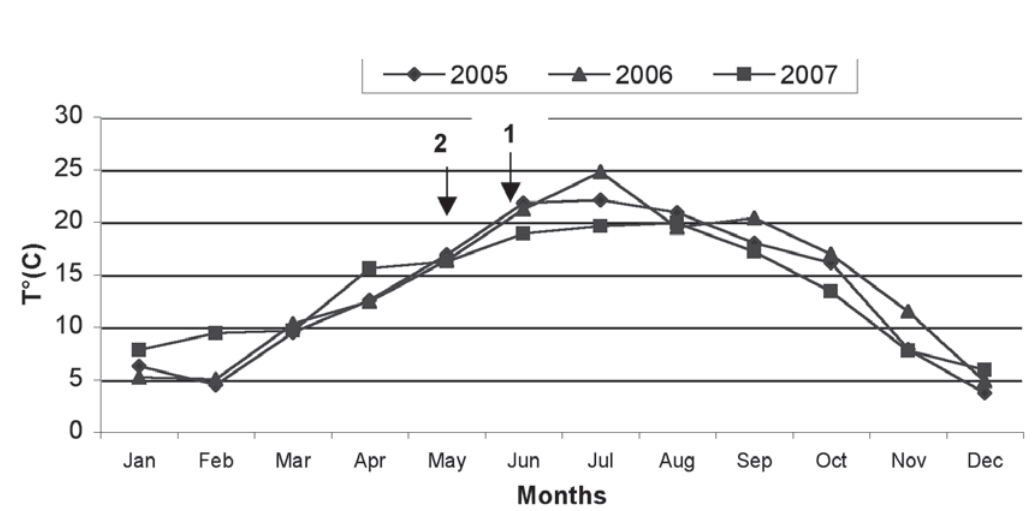
Fig. 3. Monthly temperature curves in 2005, 2006 and 2007. Arrows 1 and 2: date of inoculation in 2005 and 2006